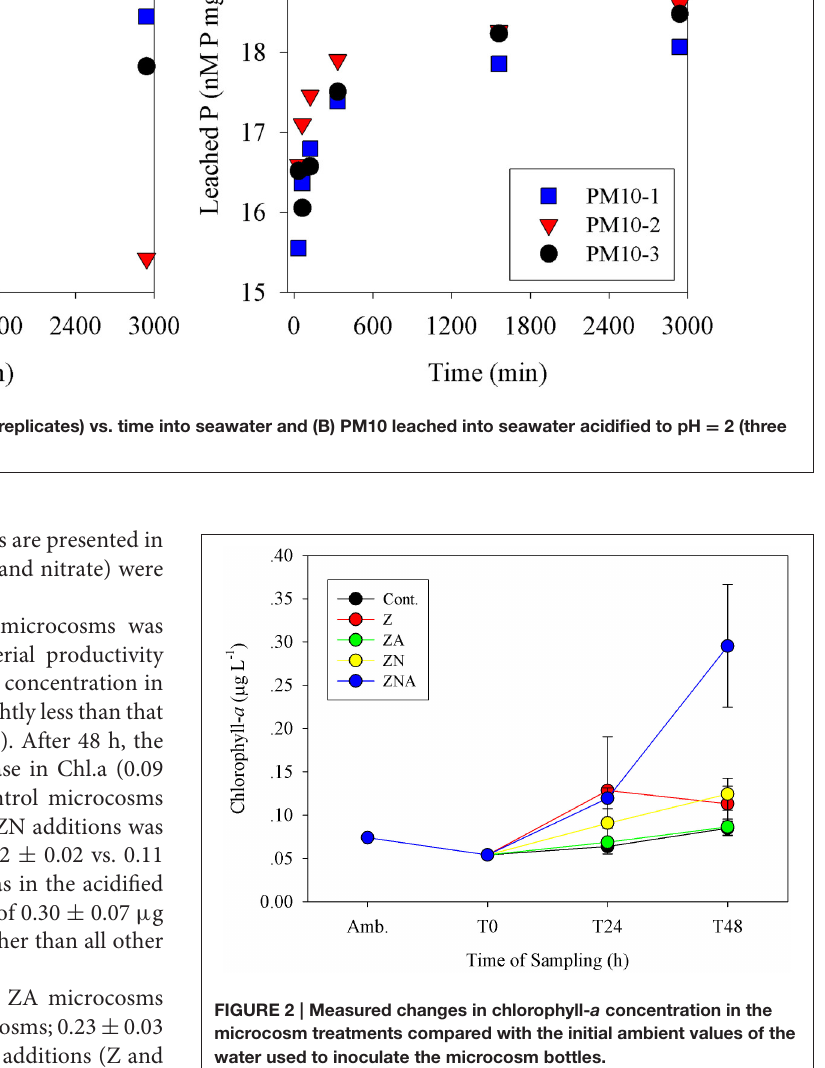
Table S3 ). For this parameter, ZN was greater (82 ng C L − 1 h − 1